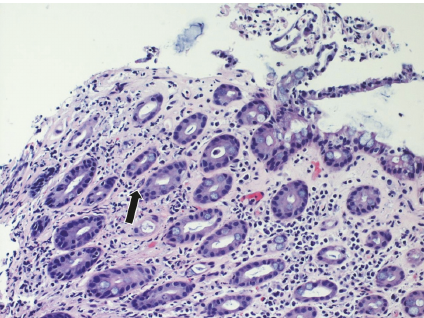
Figure 3: Colonic ulcer biopsy demonstrating ischemic morphol- ogy with hyalinization of the lamina propria and atrophic crypts. Small cystic forms are evident. The arrows refer to toxoplasmosis cyst present within the colonic ulcer biopsy.